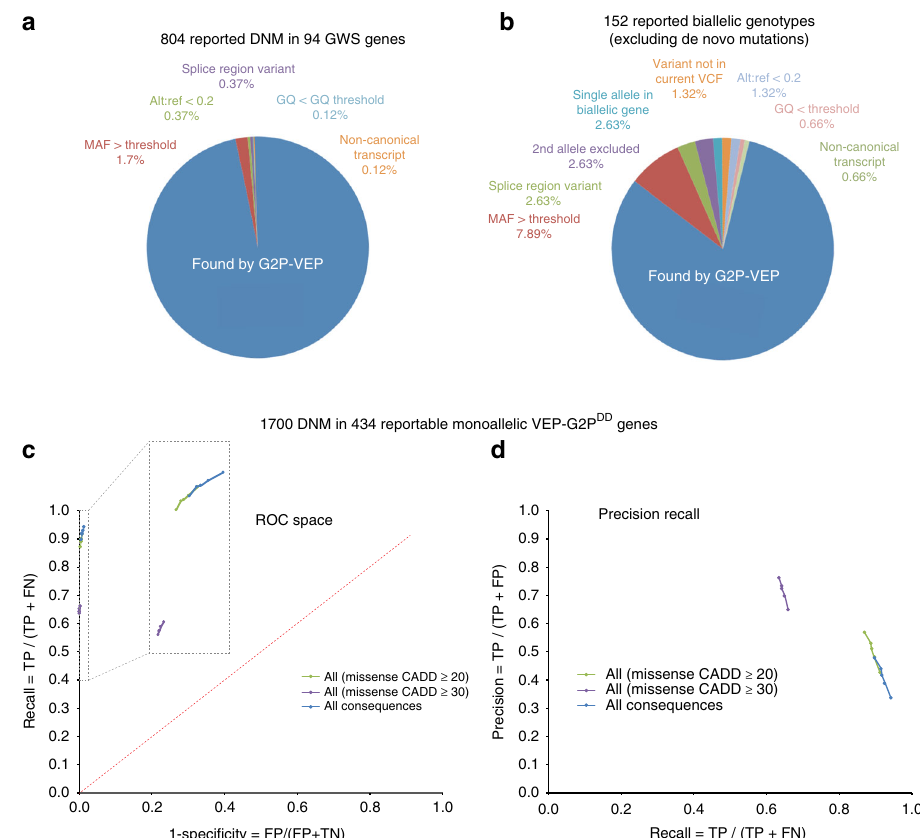
Fig. 3 Sensitivity and precision of VEP-G2P Analysis GQ genotype quality, MAF minor allele frequency, alt:ref the ratio of alternate to reference alleles. TP true positive, FP false positive, TN true negative, FN false negative. Sensitivity = TP/(TP + FN). Precision = TP / (TP + FP). a Evaluation of G2P accuracy for likely causative variants in 94 genes achieving genome-wide signi fi cance (GWS) for de novo mutations in the DDD study. b G2P accuracy against the set of variants previously identi fi ed by DDD in the fi rst 1133 samples, excluding de novo mutations. c ROC curves for VEP-G2P DD performance on 1700 DDD probands with de novo mutations (DNM) identi fi ed in the 484 monoallelic genes. The points on the curves represent varying MAF cut-offs: not seen in any control databases (bottom left), MAF < 1:100000, MAF < 1:50000, MAF < 1:25000, MAF < 1:10000 (top right). The region in the top left corner of the ROC space graph has been expanded to scale using the regions bounded by the dashed line rectangles. d The effect of consequence type and MAF on precision and recall (PR curves) of VEP-G2P DD using the same data analysed for the ROC space in c . The highest precision [0.812, 0.863] is achieved for LOF variants but with the lowest recall [0.425, 0.437]. The highest recall is achieved for variants of all consequence types [0.897, 0.942] at the cost of decreased precision [0.334, 0.476]. Analysing only missense variants with CADD ≥ 30 or CADD ≥ 20 leads to improvements in precision at the cost